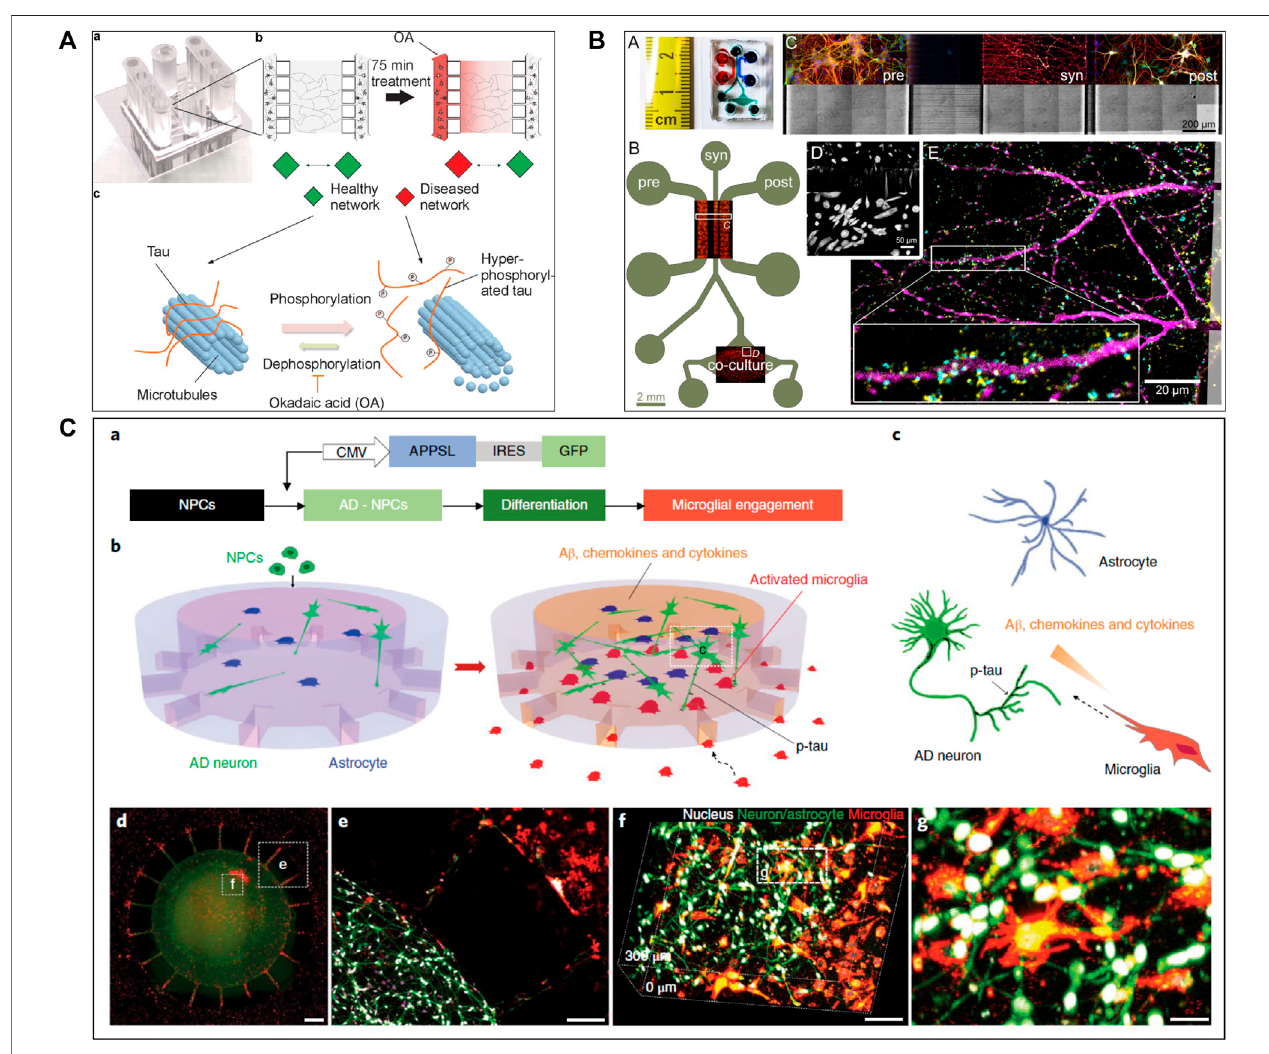
FIGURE 2 | Micro fl uidic devices used in Parkinson ’ s disease modelling. (A) Representation of α -synuclein assemblies spreading from proximal chamber to distal chamber of micro fl uidic device with 3 compartments, thanks to immuno fl uorescent staining. Scale bars represent 25 µm. Extracted from Gribaudo et al. (2019) (copyright Stem Cell Reports). (B) Schematic representation of the experiment with (C) and without (A) neurons, stained by β III-tubulin in red adding α -synuclein fi brils stained by Syn-488in green, in fi rst compartment of the micro fl uidic device. Extracted from Freundt et al. (2012) (Copyright Annals of Neurology). (C) Representation of in vitro micro fl uidic device of basal ganglia circuit with fi ve compartments representing anatomical region and connectivity. Neuronal co-culture was characterized by immuno fl uorescent pictures of cortical (V-glut in green), striatum (GABA in red), globus pallidus (PY in green) and substantia nigra (TH in red) neurons. Extracted from Kamudzandu et al. (2019) (Copyright Biomedical Physics & Engineering